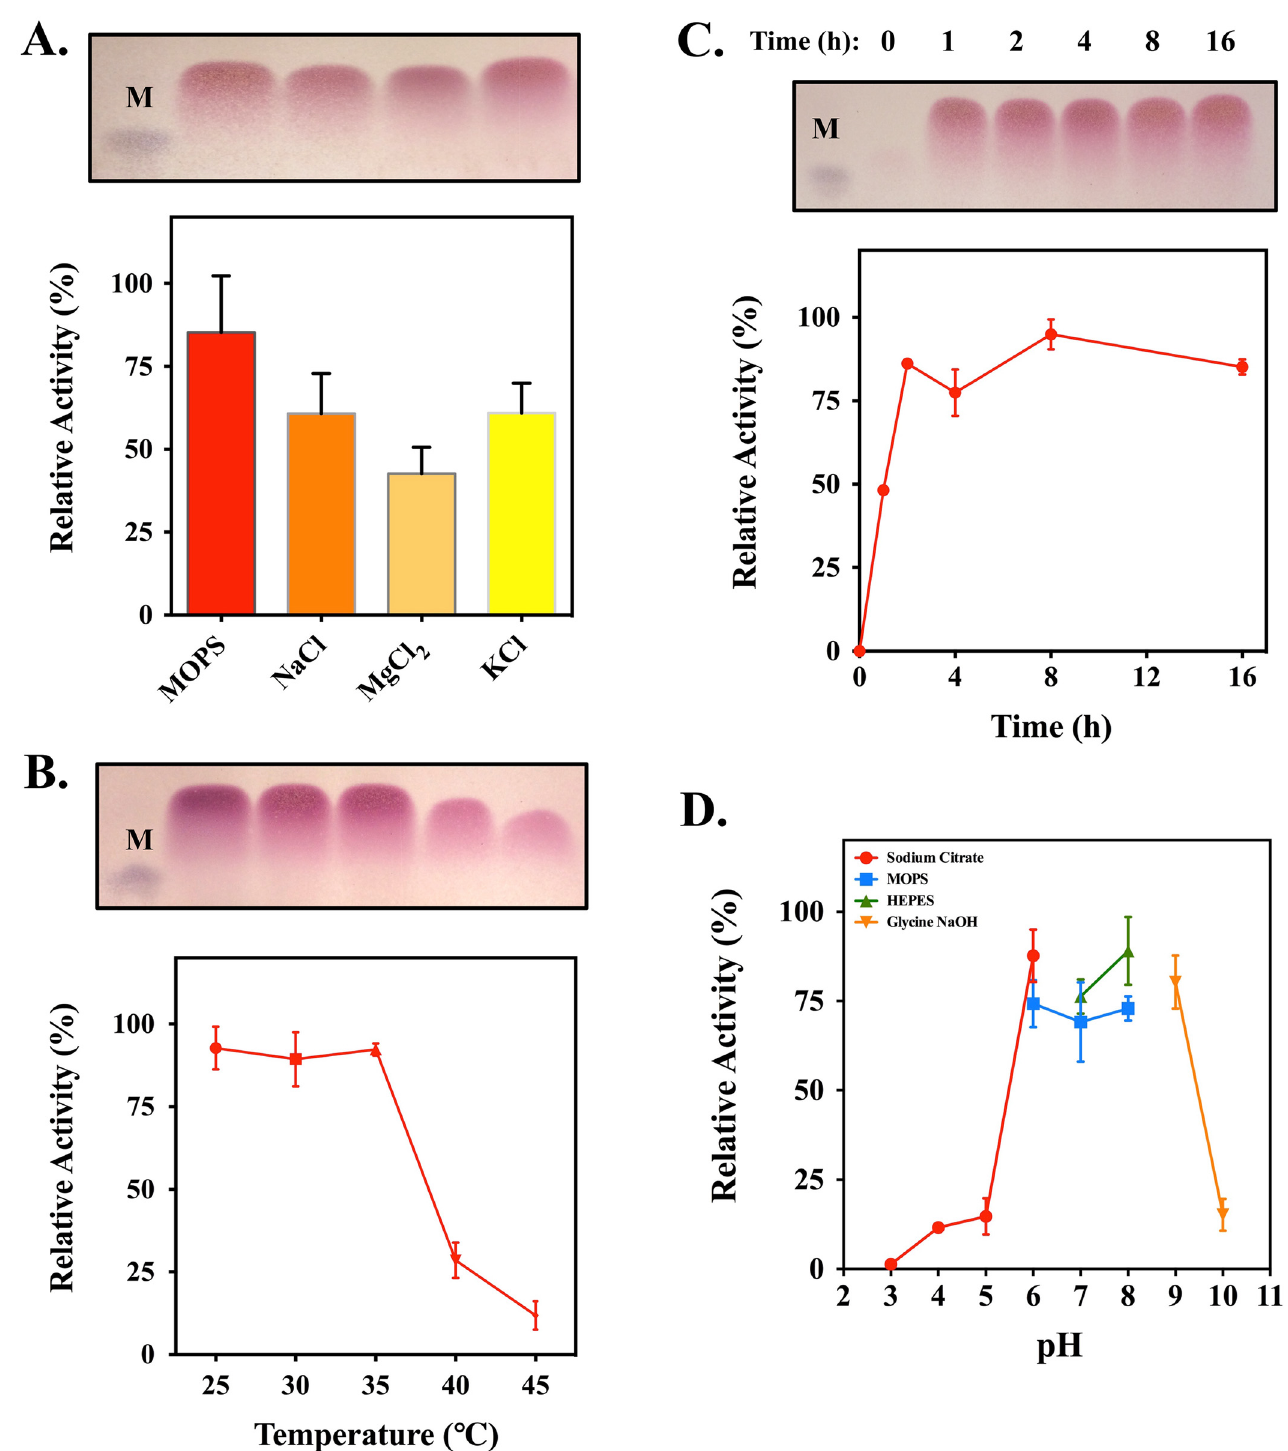
Fig 4. Enzymatic characterization of AlyFRB based on its activity in response to the respective A. cationic ions, B. temperature, C. alginate depolymerization time and D. pH, using TLC and DNS assay. In the analysis of cationic ions, the effects of Na + , Mg 2+ , K + ions were evaluated. All reactions were performed in 50 mM MOPS buffer, pH 7.0 with 1 μ g/ μ L (final concentration) of purified protein. Optimal pH analysis was performed at 30°C. Full TLC images of the degraded products for the evaluation with cationic ions, temperature and alginate depolymerization time are provided in S4 Fig in the Supporting Information section for further